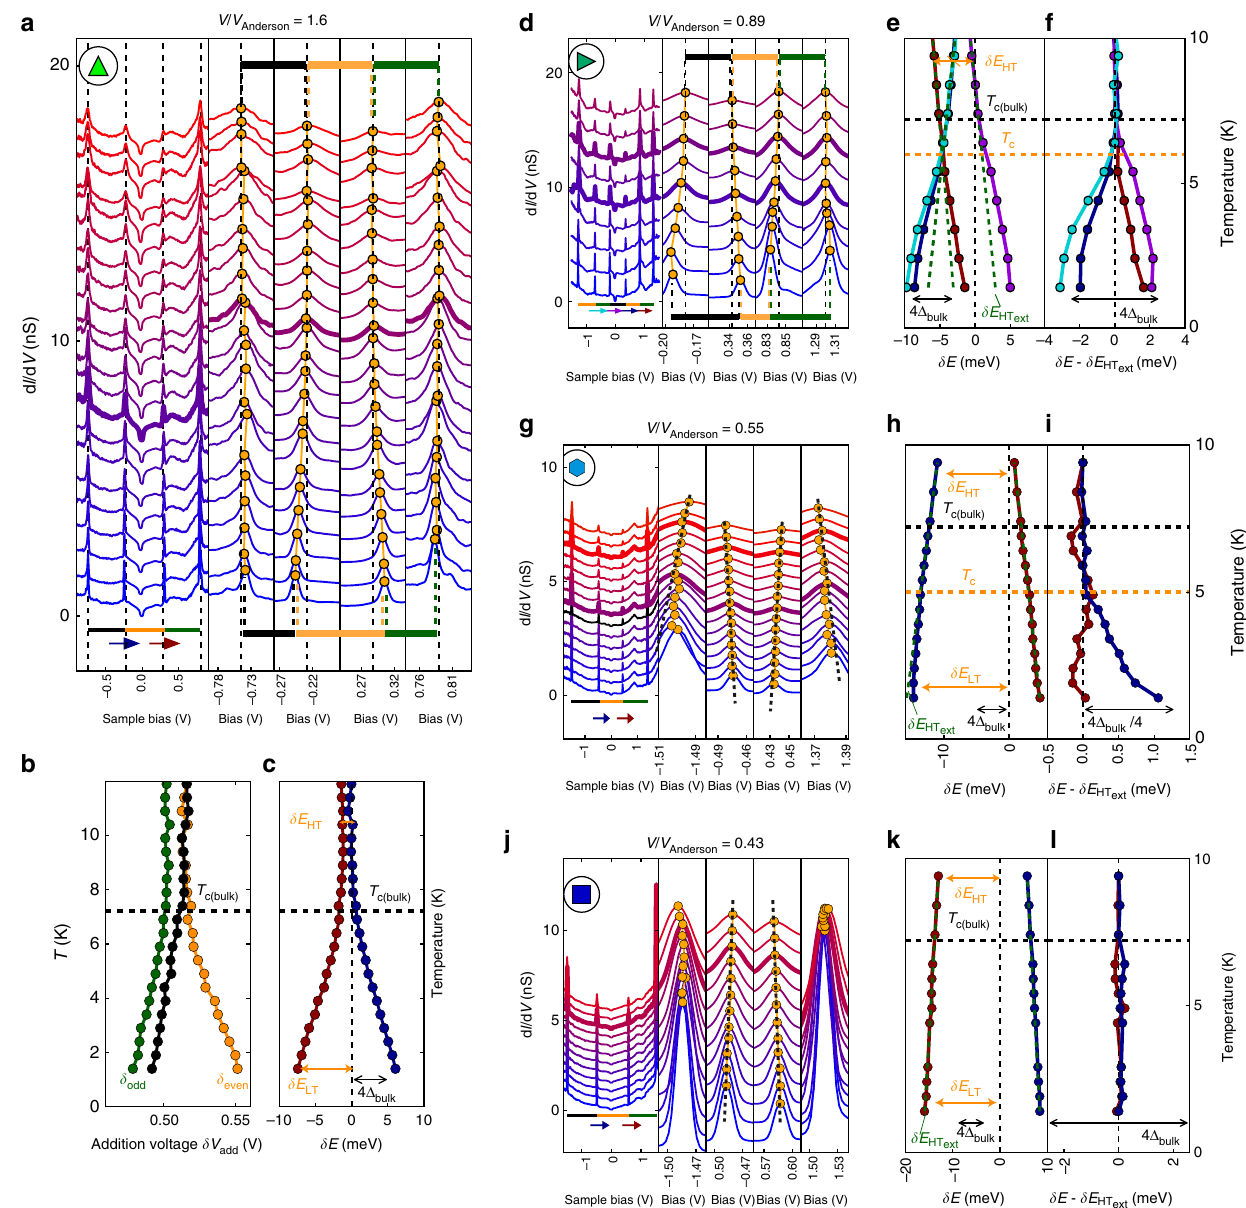
Figure 4 | Parity effect as function of temperature. DC and addition energies for four NCs of decreasing volume, where V / V Anderson is indicated on top of the panels. ( a , d , g , j ) DC curves as function of temperature. The voltage separation between the Coulomb peaks, that is, the addition voltage, is indicated by the horizontal bars of different colours. In the same panels, zoom on the Coulomb peaks are shown where the maxima are indicated by orange dots. For a , the addition voltages are plotted as the function of temperature in b with corresponding colours. The coloured symbols (top left of panels) identify the corresponding data points in Figs 2f,h and 5. ( c , e , h , k ) Difference in addition energies between two charge configurations given by d E ¼ Z ð d V Head (cid:2) d V Tail Þ , where the head (tail) refers to the arrows shown in the corresponding panels. ( f , i , l ) Difference d E (cid:2) d E HT from the extrapolation of d E at high temperature. For b , c , e , f , h , i , k , l , the value T c (bulk) is indicated as a black dash line. The extracted T c is shown as orange dash lines. A double-headed arrow provides the scale for the energy gap 4 D bulk of bulk Pb.